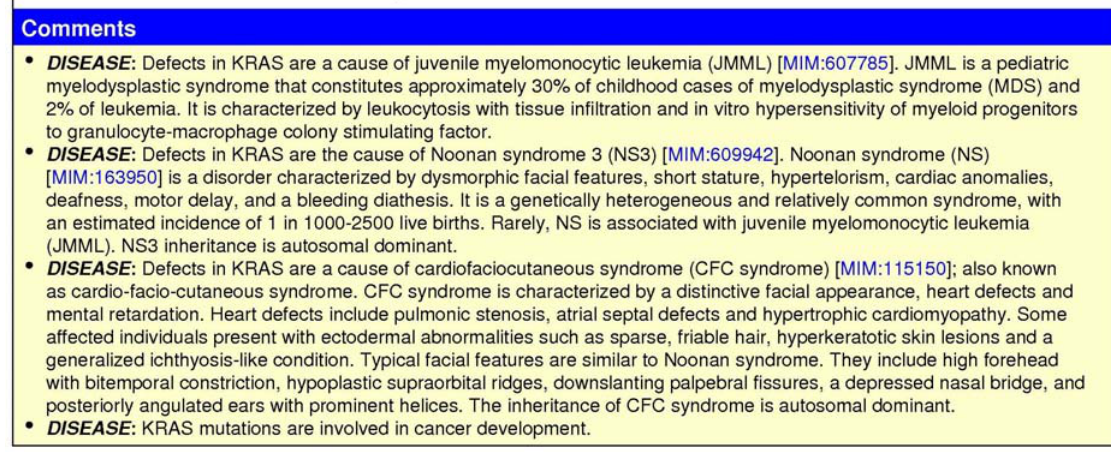
Figure 1: disease comment lines in a UniProtKB/Swiss-Prot